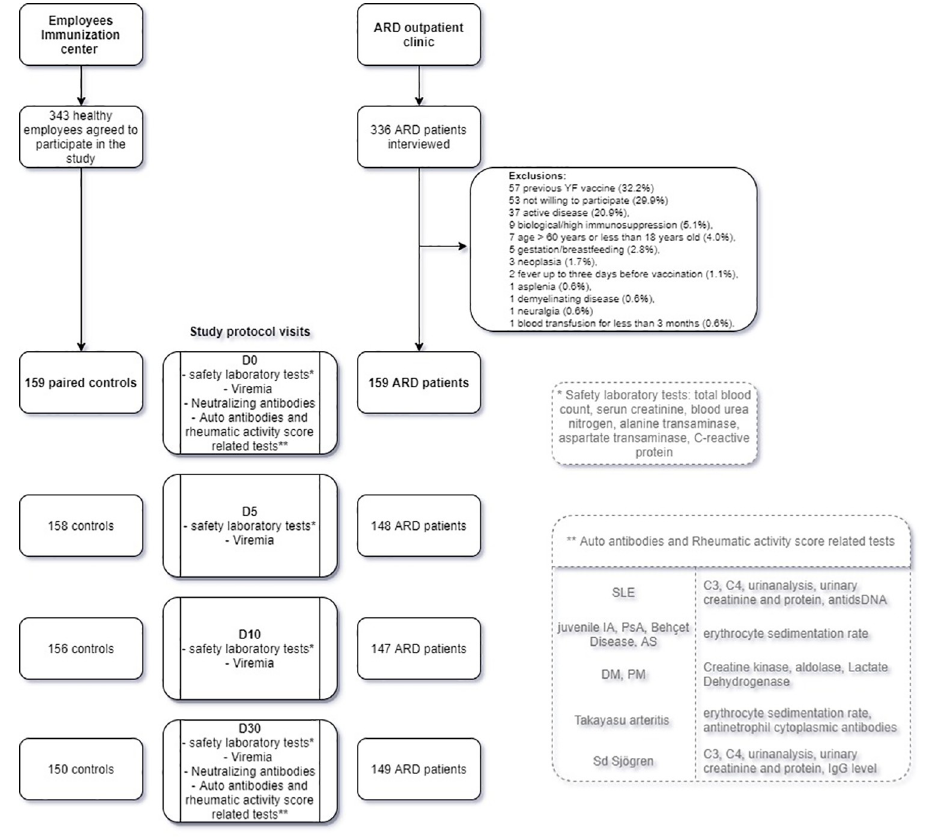
Fig 1. Study flow